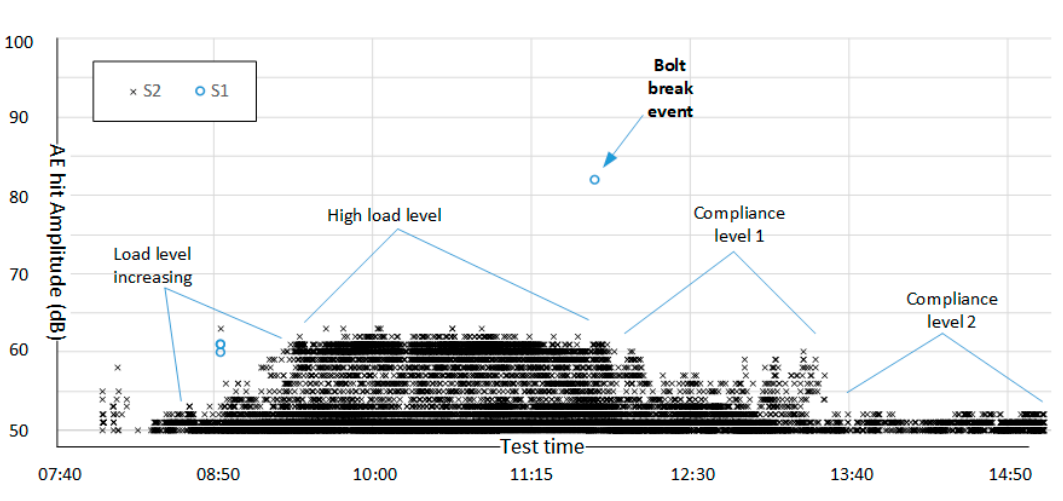
Figure 9. AE amplitude distribution for blade test during bolt failure incident.